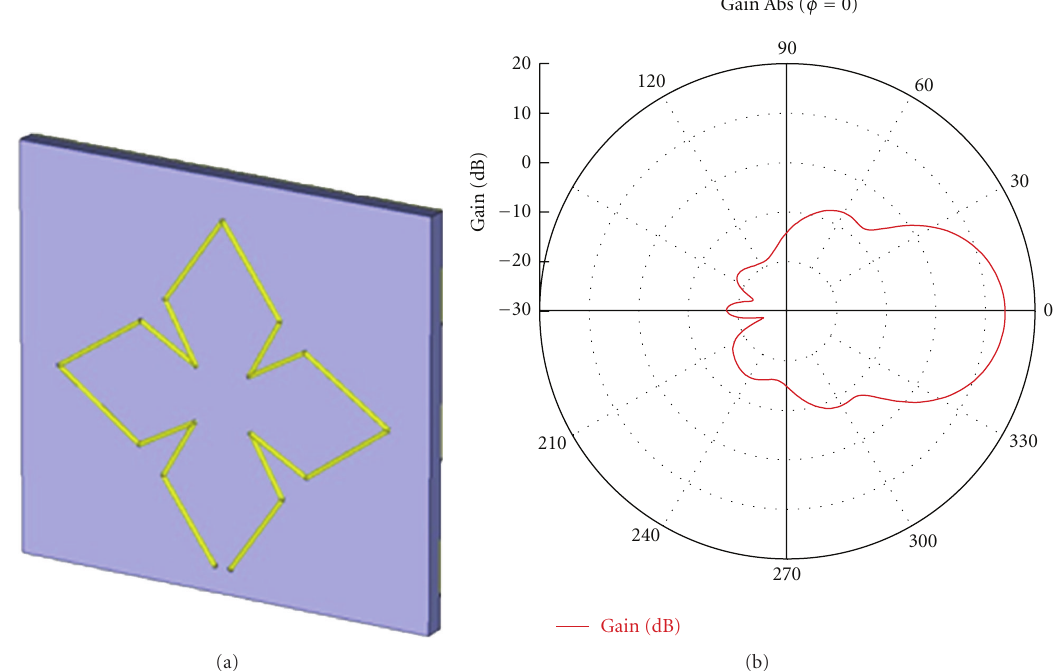
Figure 1: (a) The Cross-Rhombic Antenna and (b) its radiation pattern ( φ = 0 ◦ cut).